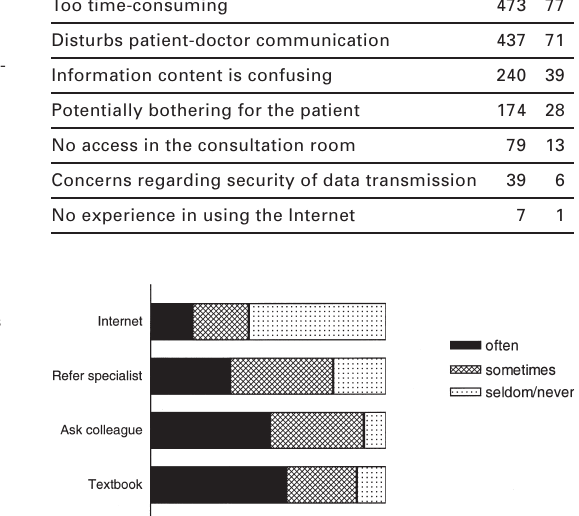
Reasons for not using the Internet during primary care consultations (multi- ple answers were possible, n = 614) .